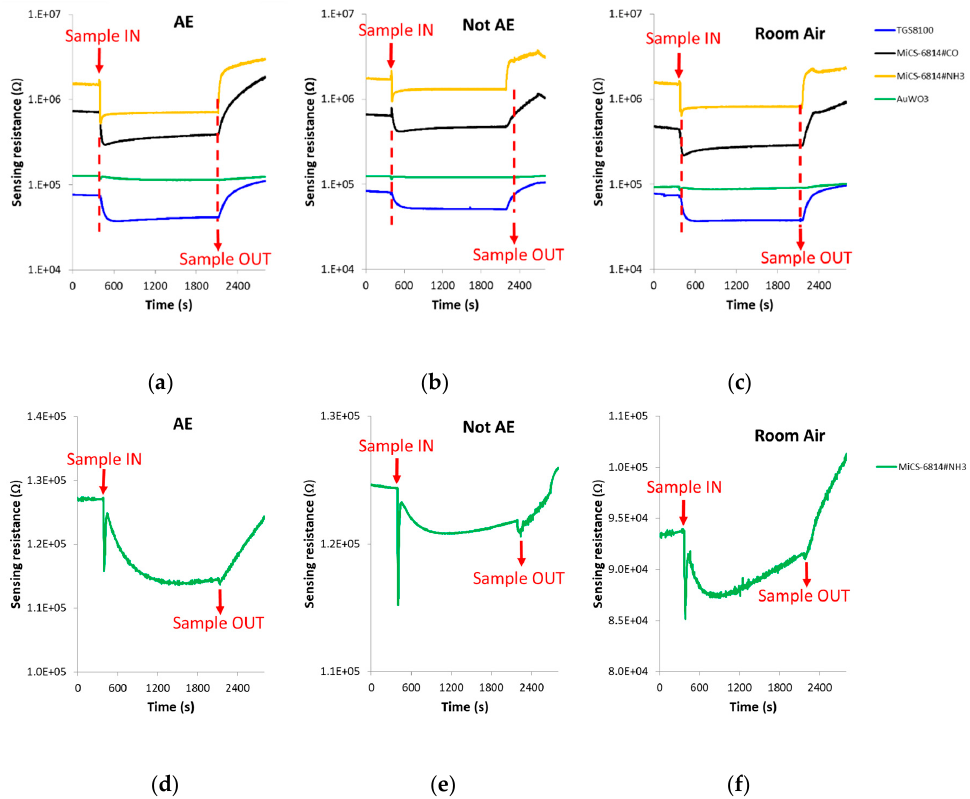
Figure 4. DC sensors responses in the presence of: ( a ) Breath sample of a patient with confirmed echinococcosis; ( b ) Breath sample of a control volunteer; ( c ) Room air. ( d – f ): Zoom of the AuWO 3 sensor responses presented in Figure 4 a – c , respectively. AE: Alveolar echinococcosis; Not AE: Control.